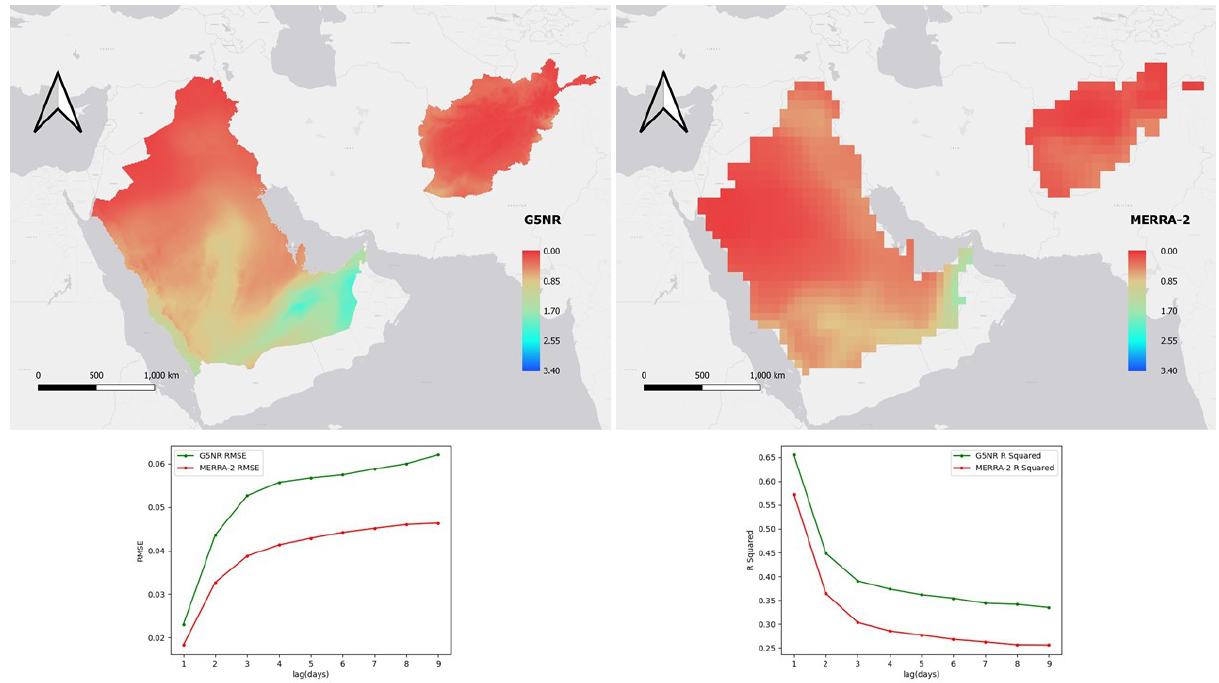
Figure 5. Sample images from G5NR ( top-left ) and MERRA-2 ( top-right ) on 29 July 2006; temporal trend of image-wise RMSE ( bottom-left ) and R 2 ( bottom-right ) with different lags (days). Model performance results comparing ASDM and ASDMTE against SRDRN, GAM and LM are shown in Appendix Figures A1–A4. Both ASDM and ASDMTE outperformed other methods, as indicated by higher image-wise R 2 and lower RMSE across all seasons and directions. Among all of the test sets, ASDMTE had average maximum image-wise R 2 =0.758 and average mean image-wise R 2 =0.443. The ASDM performed similarly with average maximum image-wise R 2 =0.735 and average mean image-wise R 2 =0.431. The SR- DRN, GAM and LM methods had average maximum image-wise R 2 =0.313, 0.106 and 0.095 respectively. Notably, the downscaled AOD map generated by ASDMTE and ASDM on 29 July 2006 (Figure 6a,b) preserved very similar spatial characteristics as the true G5NR data in Figure 6d, while SRDRN and dissever-based downscaling results (see Figure 6c,e,f) exhibit clearly different